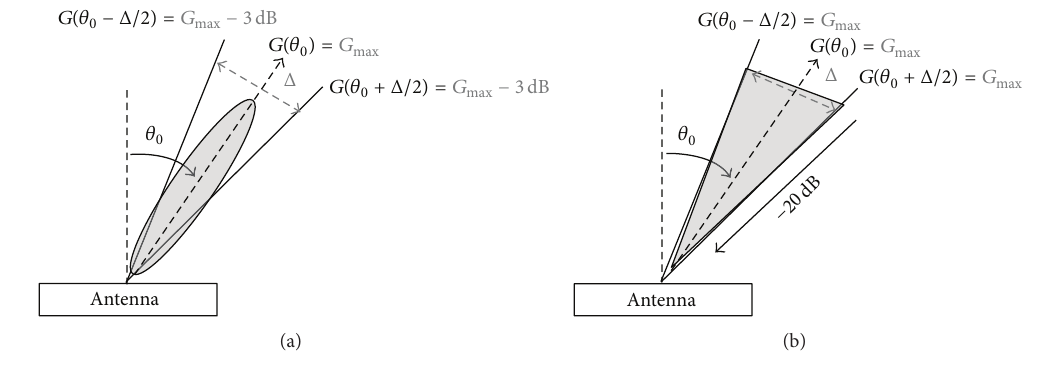
Figure 10: Illustration of the Gaussian beam radiation (a) and the proposed sectorial beam radiation (b) steered at 𝜃 0 direction.